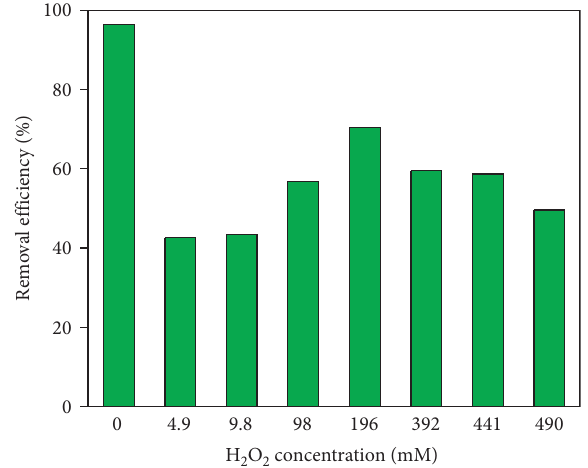
Figure 8: Effects of adding H 2 O 2 (pH 8.0, 0.15g TNTs, 1 UV-A light bulb, 90min of reaction